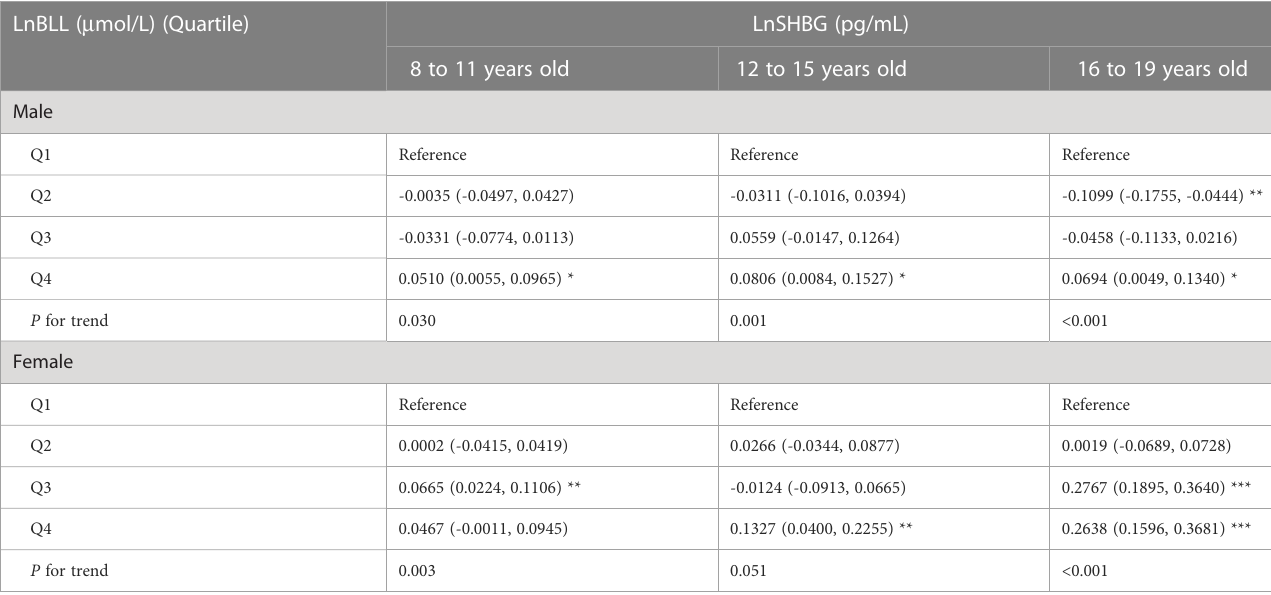
TABLE 3 Association between LnBLL ( m mol/L) and LnSHBG (pg/mL) Strati fi ed by race/ethnicity and sex. LnBLL ( m mol/L) (Quartile)